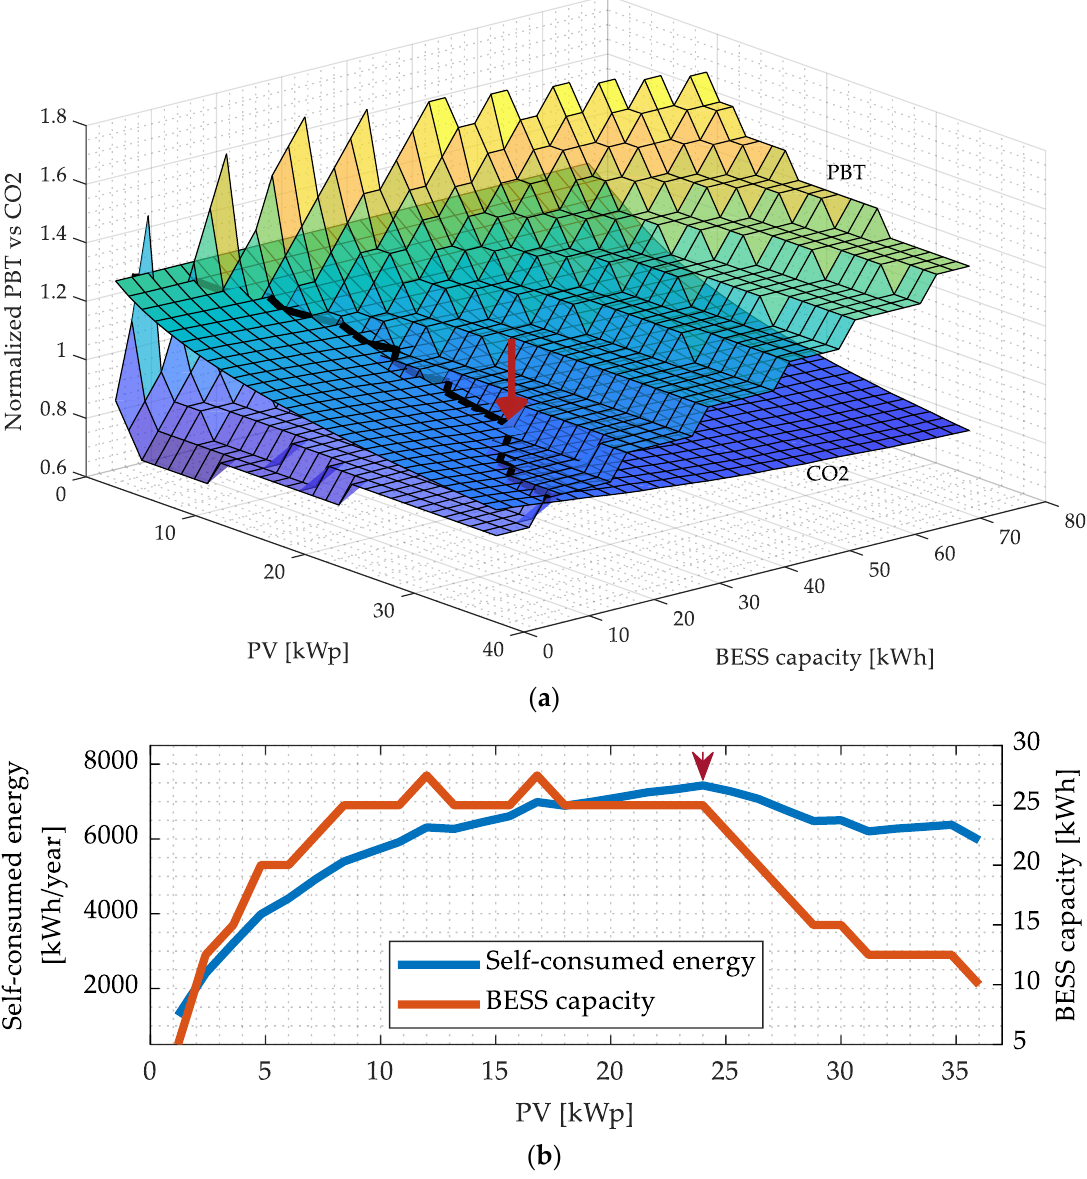
Figure 7. ( a ) Normalized PBT vs. total CO2 emissions for Scenario 5 . The black line represents the intersection of the two surfaces; ( b ) total self-consumed energy values and BESS capacity for the trade-off points considered for Scenario 5.